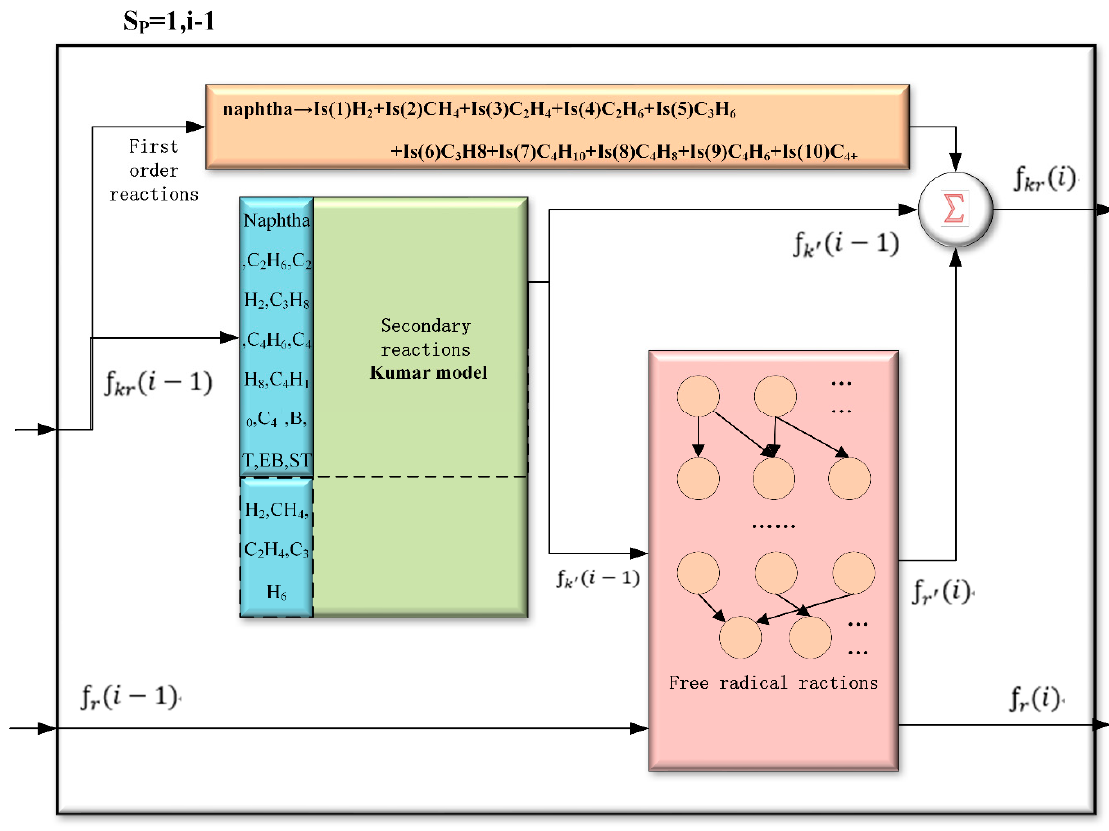
Figure 2. The K-R model (reaction model).